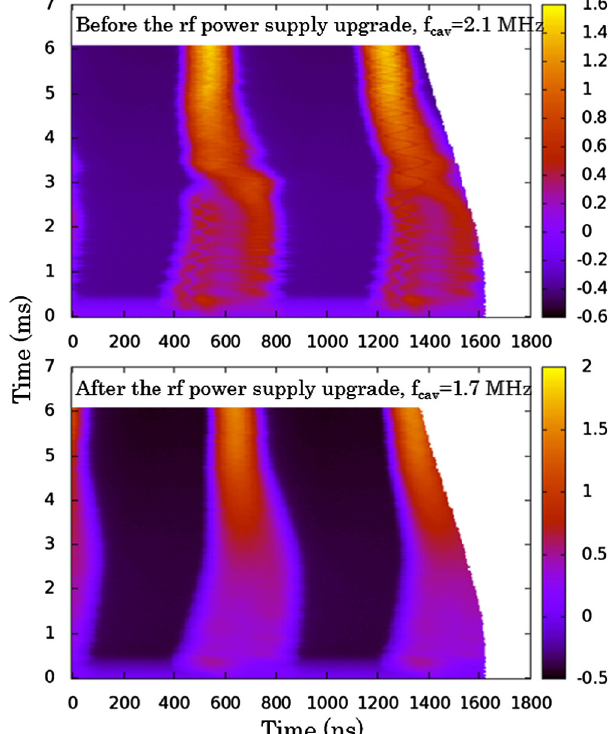
FIG. 26. Mountain plots of the wall current monitor measured for the beam intensity of 1 MW before (upper) and after (lower) the rf power supply upgrade.